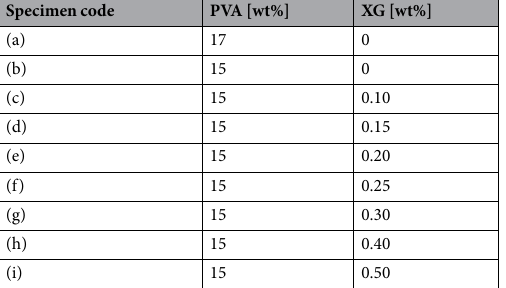
Table 2. Mixture ratios of PVA into DMSO aqueous solution and XG into the PVA